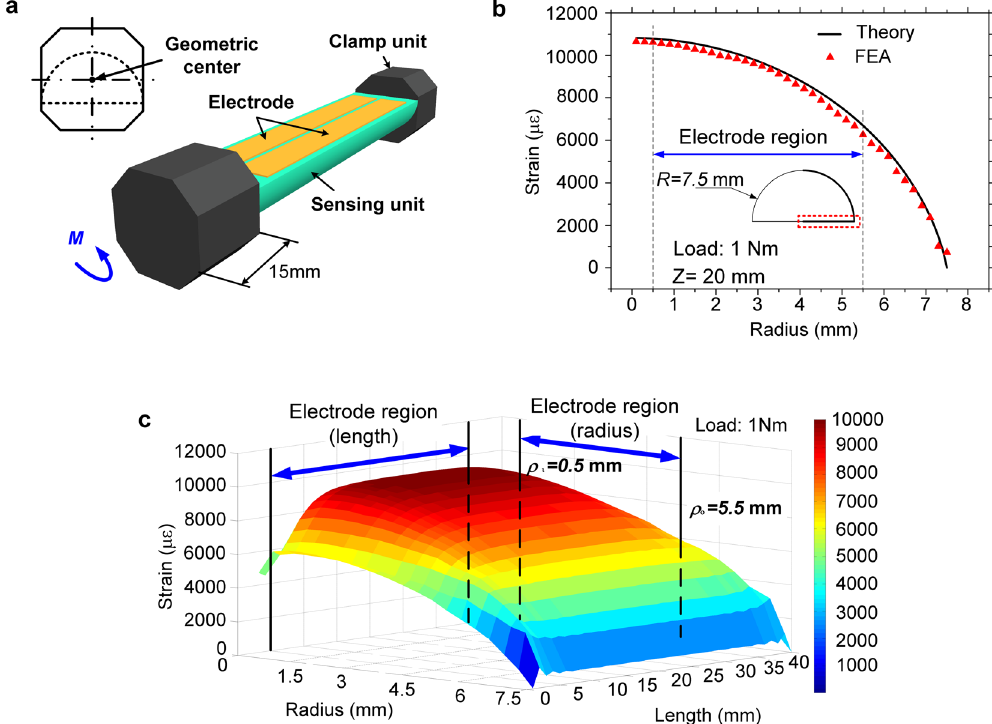
Figure 2. The design of the specimen with its mechanical properties analysis. ( a ) The shape of the specimen with the geometric center and ( b ) the comparison of the theoretical and FFA strain distribution on the section of z = 20 mm, and ( c ) the general strain distribution of the whole measured surface.